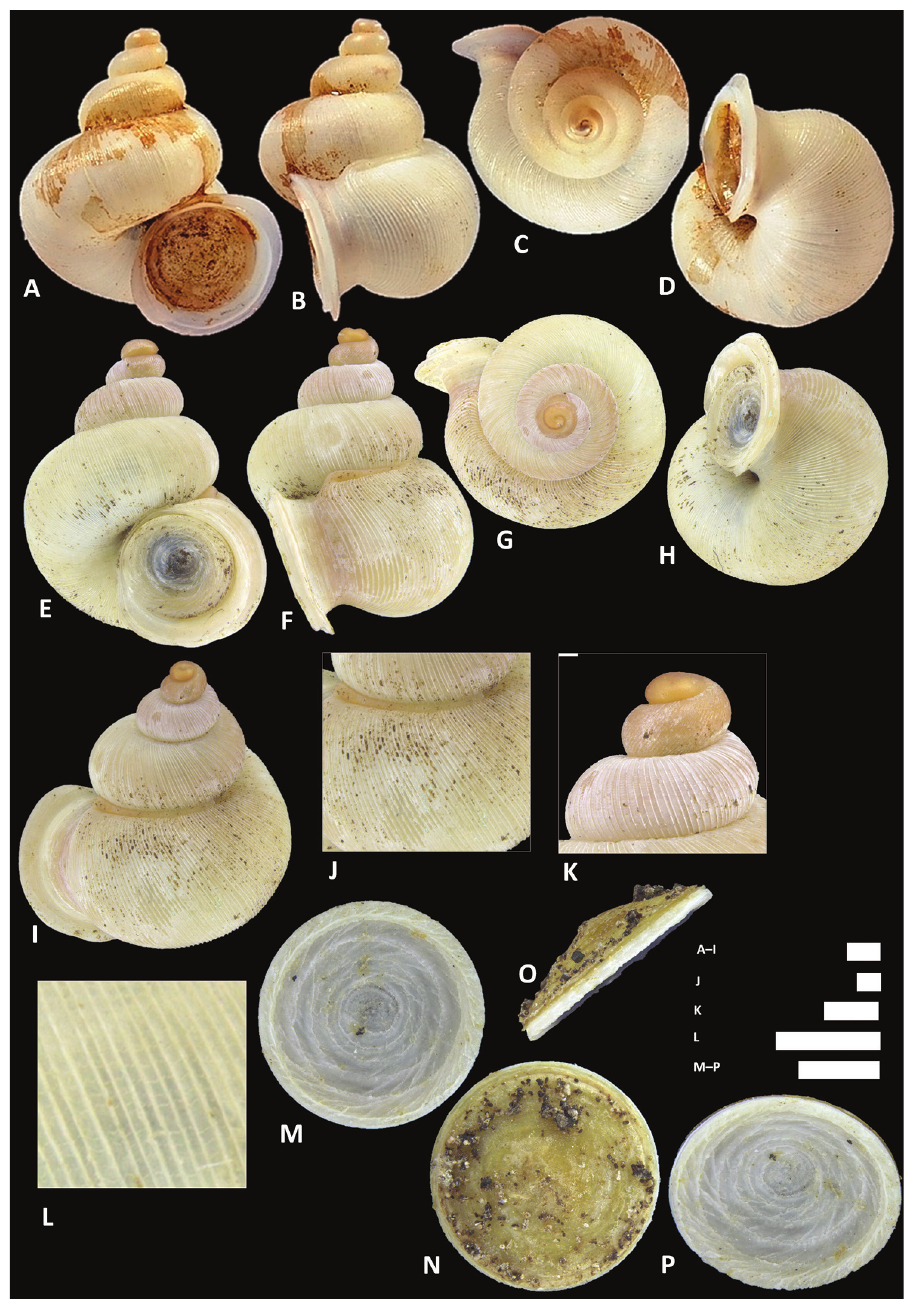
Figure 14. Alycaeus conformis Fulton, 1902. A–D Shell of syntype, NHMUK 1902.5.28.22-23 E–I Shell of BOR/MOL 6526 J–L Close up of shell of BOR/MOL 6526 M–P Operculum of BOR/MOL 12986. Scale bars: A–P 1 mm. Photographs A–D by Harold Taylor (copyright of NHM, reproduced with per- mission). Photographs E–P by Junn Kitt